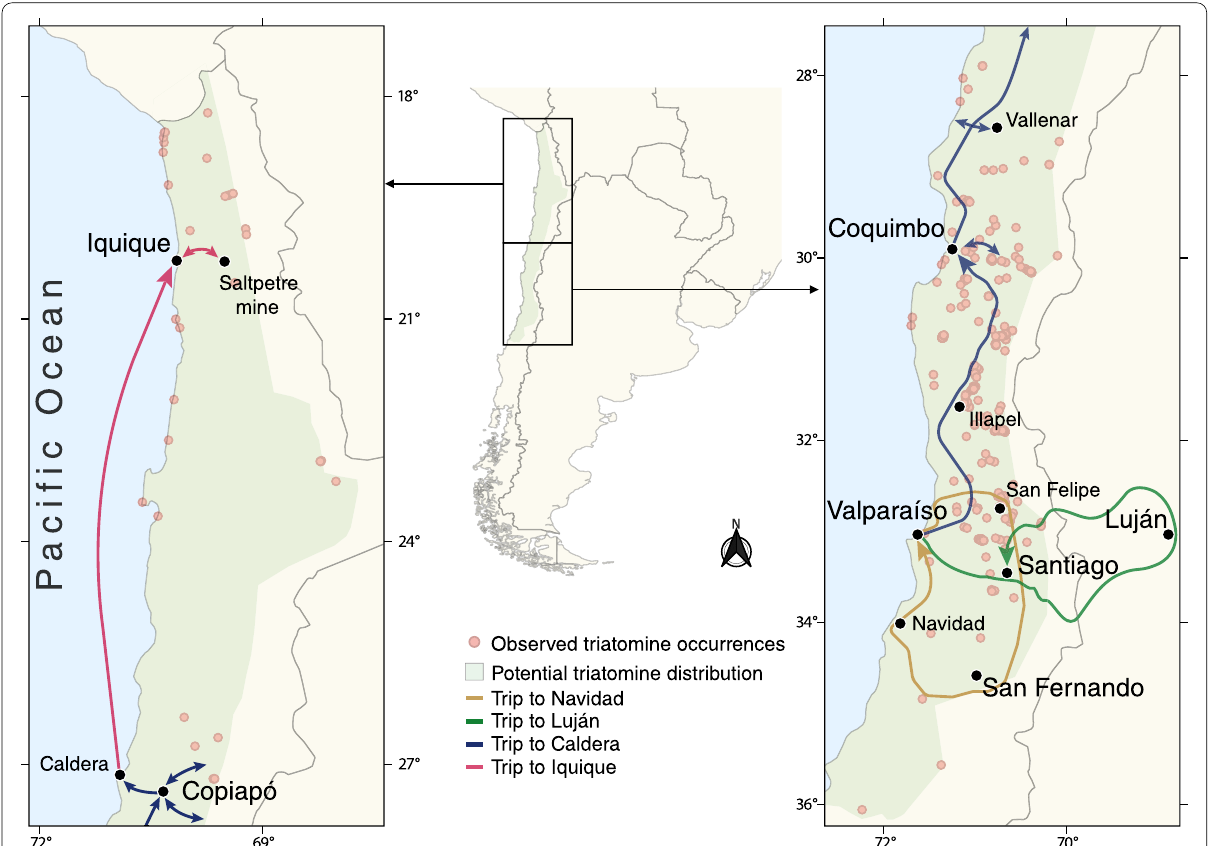
Fig. 1 Map depicting the routes followed in Darwin’s four trips performed between 1834‑1835 to north‑central Chile, a hyperendemic area of Chagas disease. Trip to Navidad (1834): 14‑27 August, 6‑27 September (Valparaíso ‑ Campana mountain ‑ Santiago ‑ Cauquenes Hot Spring ‑ Navidad ‑Valparaíso). Trip to Luján (1835): 18 March ‑ 10 April (Santiago ‑ Piuquenes Pass ‑ Luján ‑ Mendoza ‑ Uspallata Pass ‑ Santiago). Trip to Caldera (1835): 27 April ‑ 5 July (Valparaíso ‑ Limache ‑ Illapel ‑Coquimbo ‑ Freirina ‑ Vallenar ‑ Copiapó ‑ Caldera). Trip to Iquique (1835): 13‑14 July